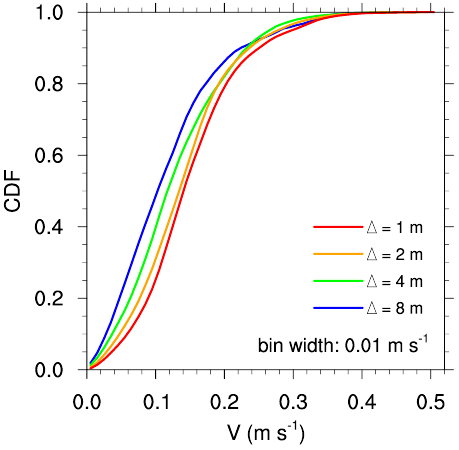
Figure A1. Cumulative distribution function of three-dimensional wind velocity V at 4m height. Data are averaged over